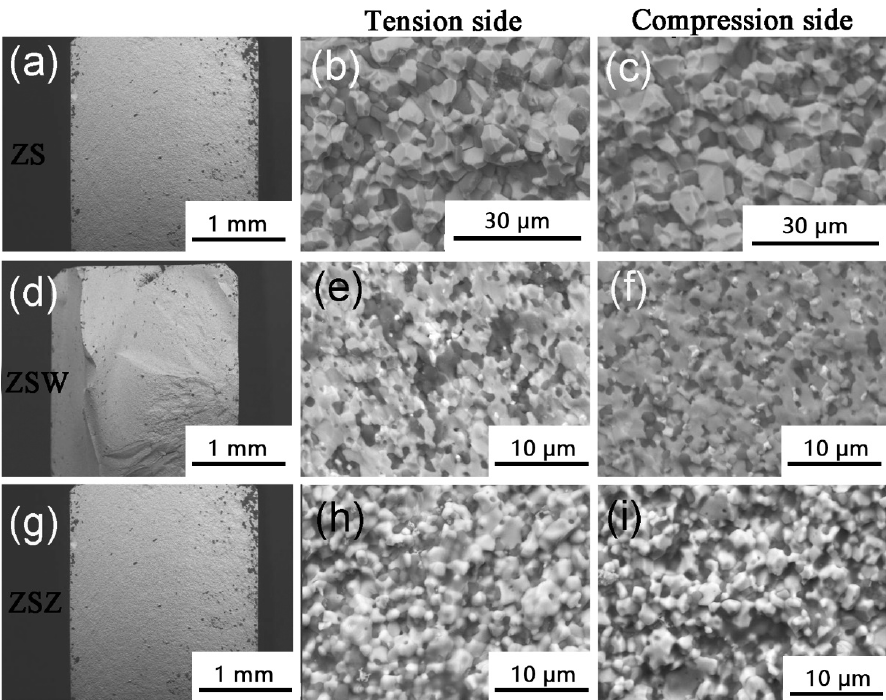
Fig. 5 Flexural surfaces of ZrB 2 –SiC (ZS) (a–c), ZrB 2 –SiC–WC (ZSW) (d–f), and ZrB 2 –SiC–ZrC (ZSZ) (g–i) at 1600 ℃ . Reproduced with permission from Ref. [131], © The American Ceramic Society